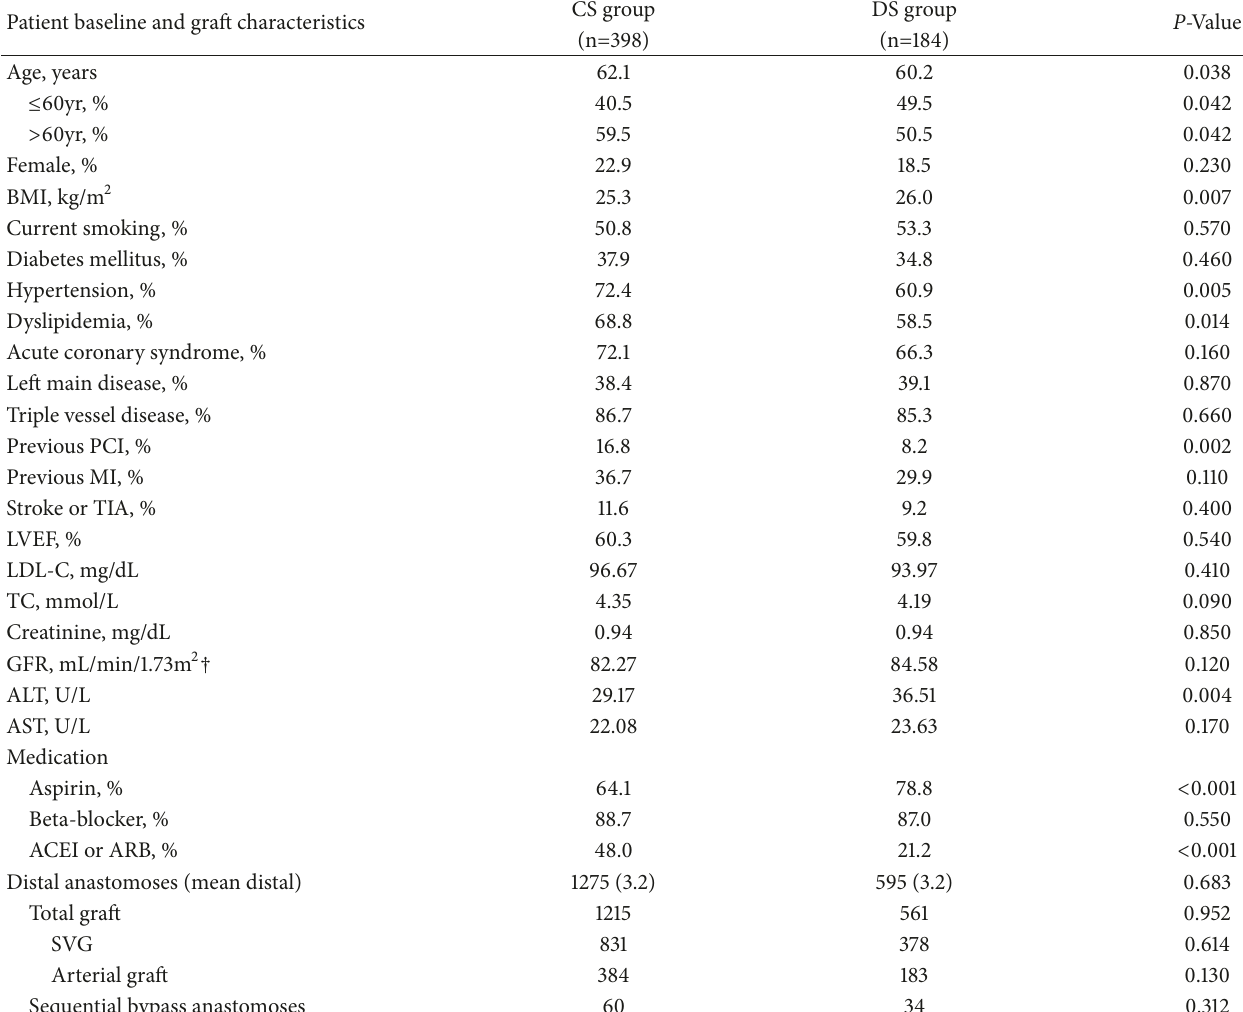
Table 1: Baseline and graft characteristics of overall patient before IPW